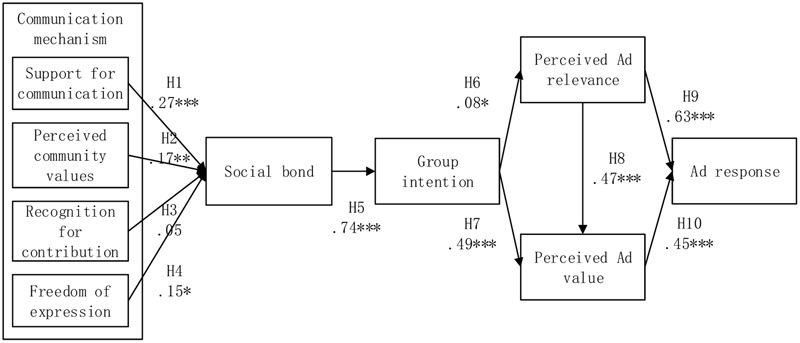
Structural model and analysis results. ∗p < 0.05; ∗∗p < 0.01; ∗∗∗p < 0.001.